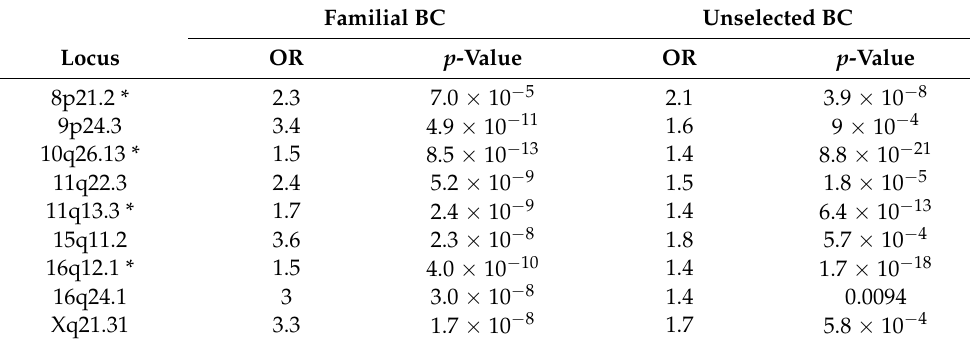
Each genetic locus with the gene in the area (if any), first (SNP1) and last (SNP2) and corresponding frequency (F), odds ratio (OR), and p -value. Reference panel GRCH37 for SNPs. * Previously published locus [11]. Table 2. Comparison of breast cancer risk loci in present familial and a previous unselected breast cancer GWAS.